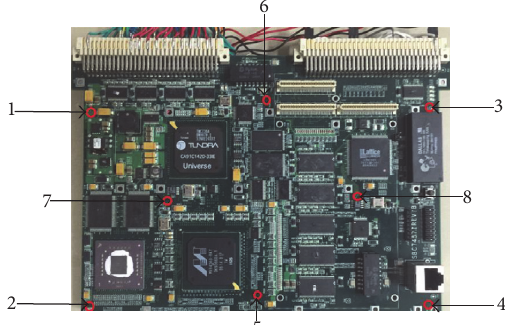
Figure 2: Test board and acceleration sensor